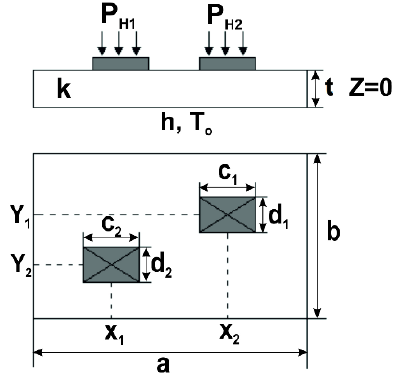
Figure 6. Diagram of Muzychka solution for a plate with two heat sources.